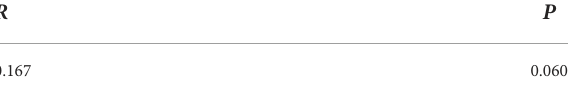
TABLE 6 Correlation between the T-tau level in CSF and NPI score in patients with PD.